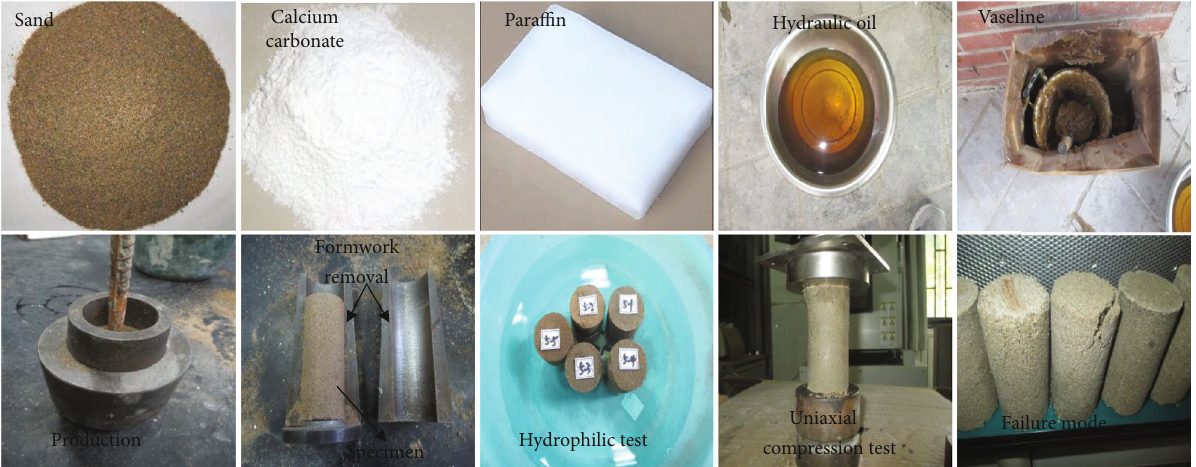
Figure 9: Raw materials and the production process.